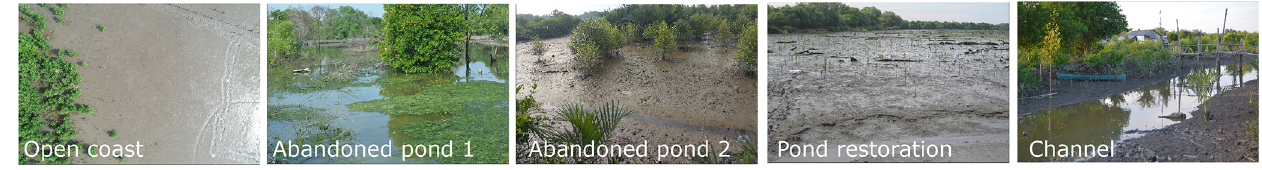
Figure 6. Photographs of deployment sites in North